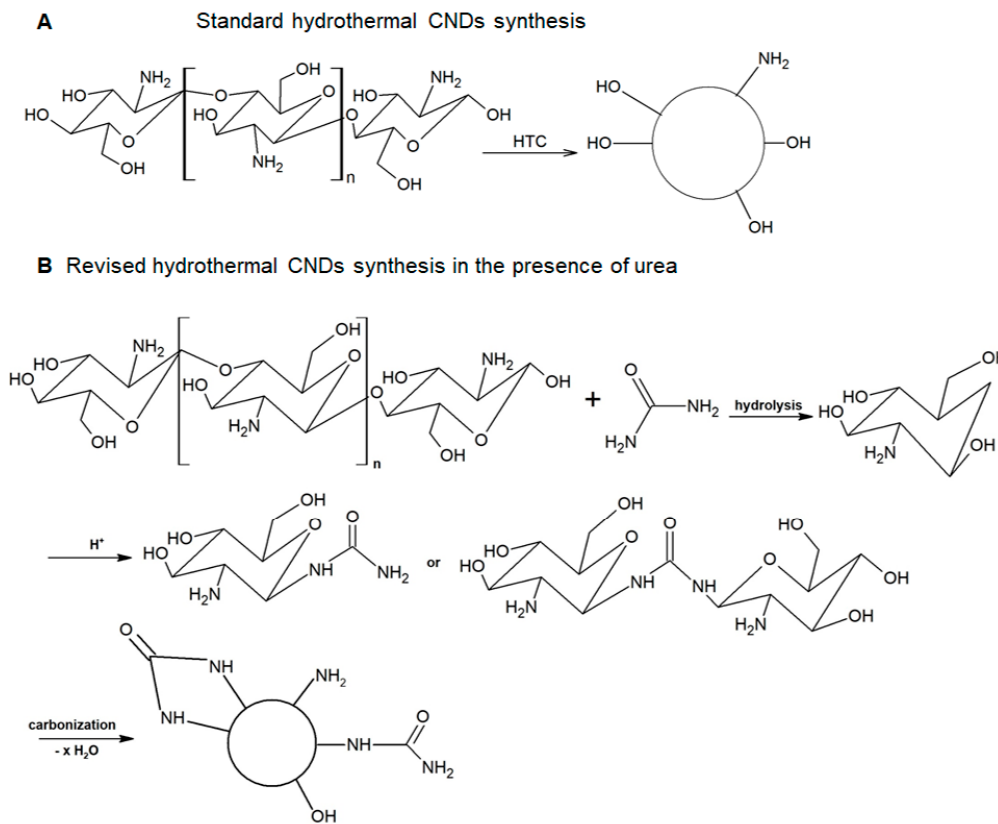
Processes 2021 , 9 , x FOR PEER REVIEW Figure 3. The proposed CNDs formation during hydrothermal carbonization of chitosan and chitosan with urea.